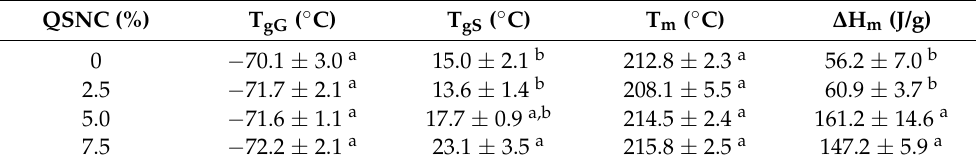
Table 3. Cassava film thermal properties with quinoa starch nanocrystals (QSNC) at different concentrations *. QSNC (%) T gG ( ◦ C) T gS ( ◦